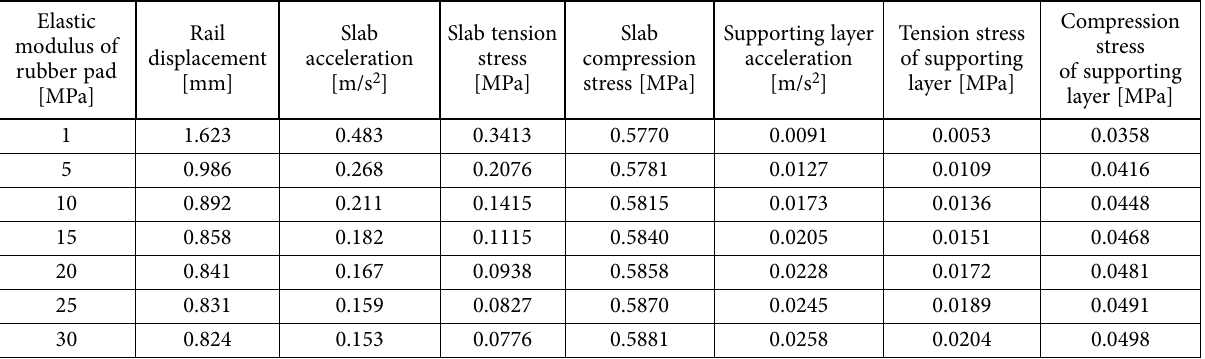
Table 3. Effect of elastic modulus of rubber pad on dynamic characteristics of track structure Elastic modulus of